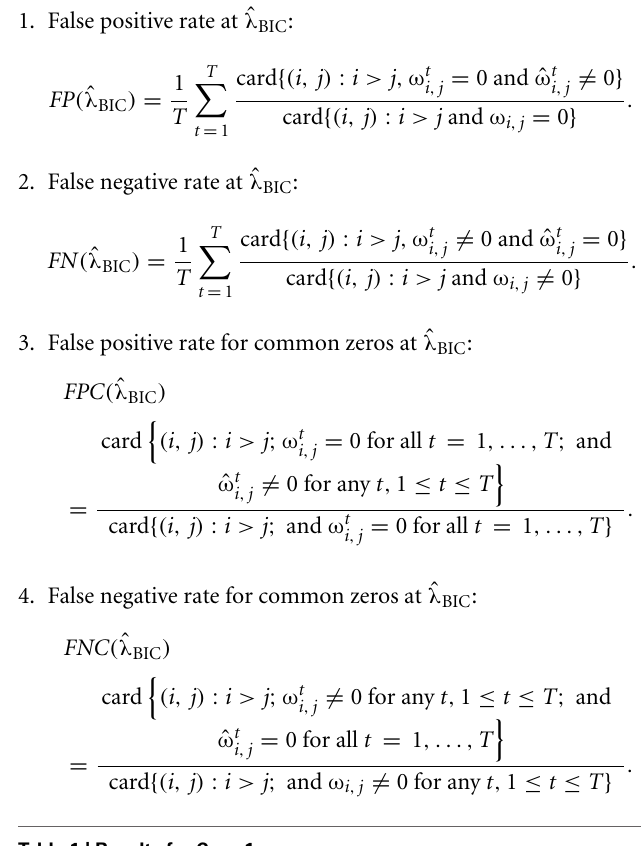
Table 1 | Results for Case